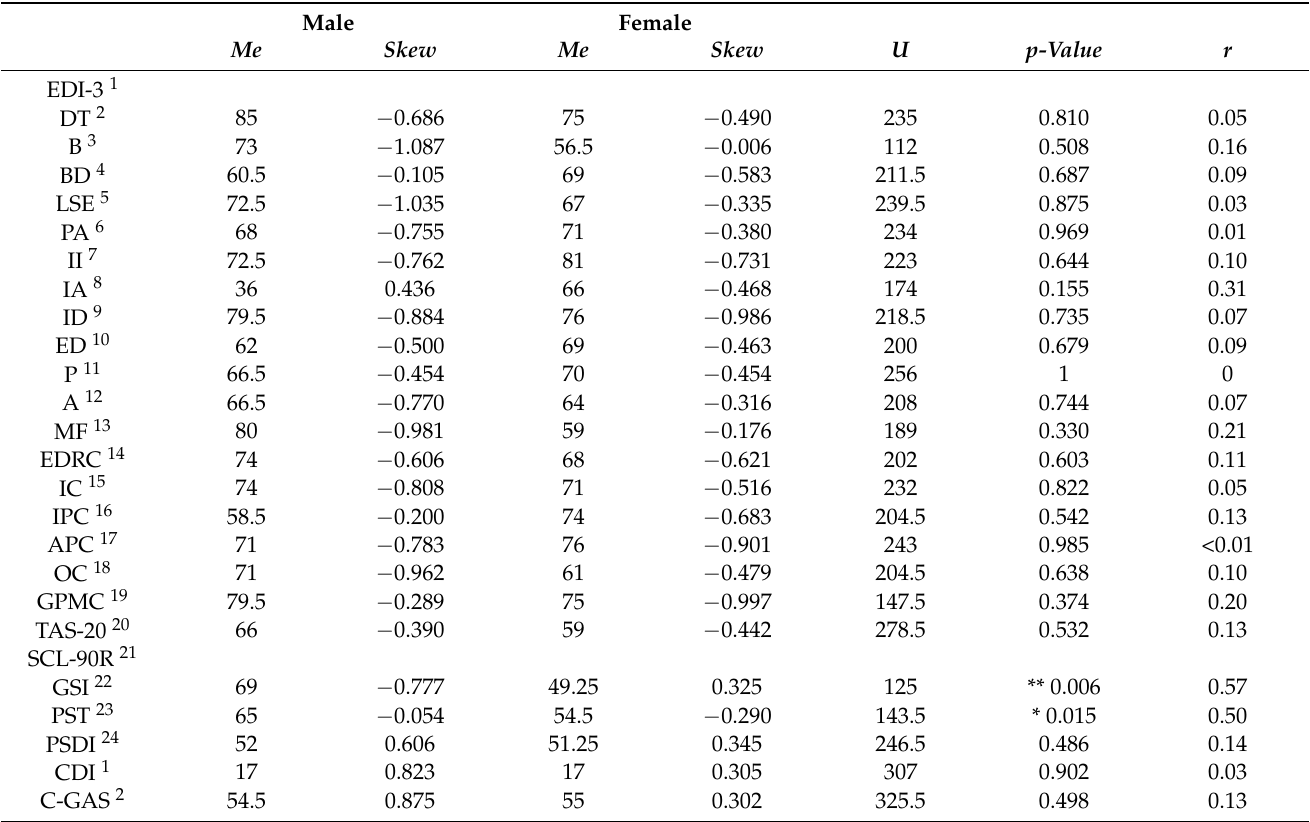
Table 6. Differences in psychological features in Early adolescents.